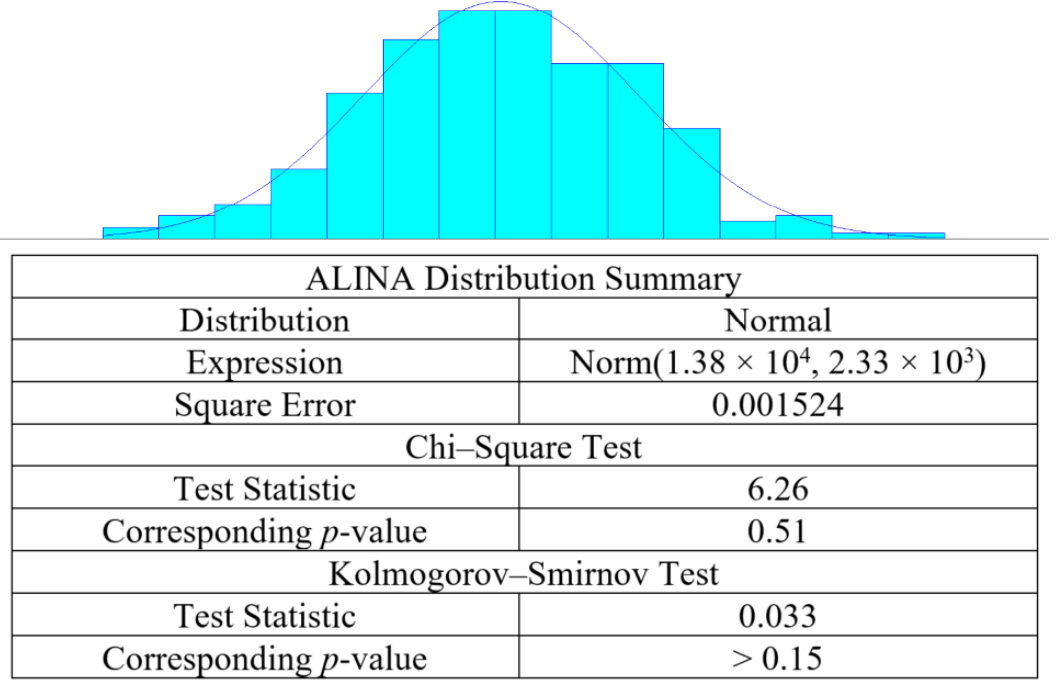
Figure 7. The probability distribution of the consumption of drug ALINA.